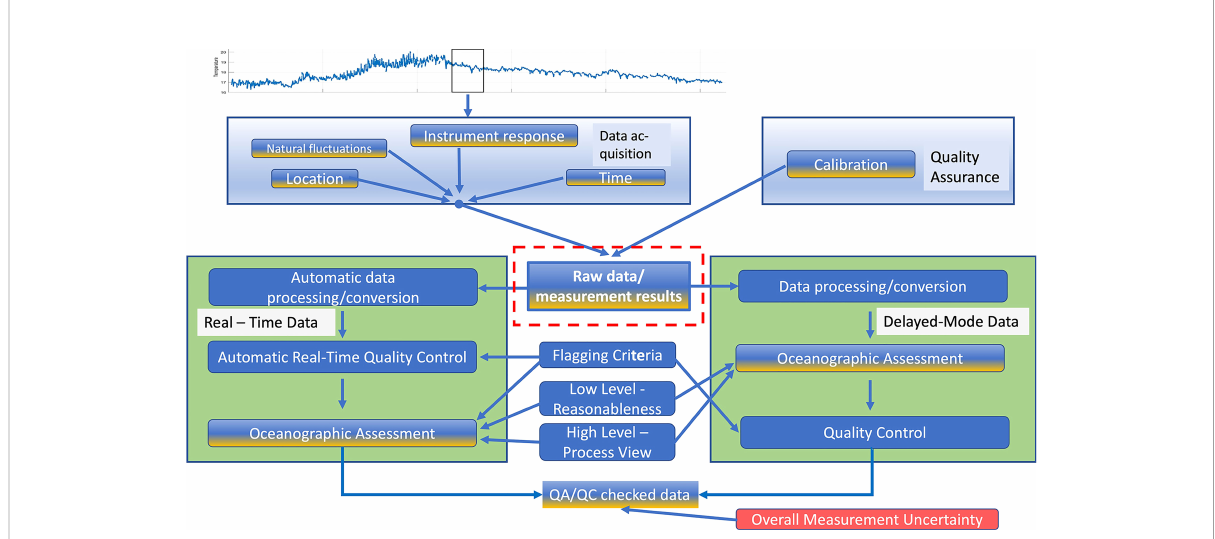
FIGURE 9 Schematic of information (blue) fl ow and their corresponding uncertainty (yellow) de fi ning a single fi eld measurement. The top part shows the environmental signal which is intended to be measured. The data acquisition box shows the different information and their uncertainty a measurement is facing: natural fl uctuations of the environmental signal between the selected sampling interval, the sensor response capabilities, related measurement of time facing clock drift or data storage delays, uncertainty of location because of movement within the water column or if bottom mounted, change of water depth due to tidal effects. The quality assurance box is representing the information an uncertainty from the sensor calibration as detected in the laboratory under stable and well-known